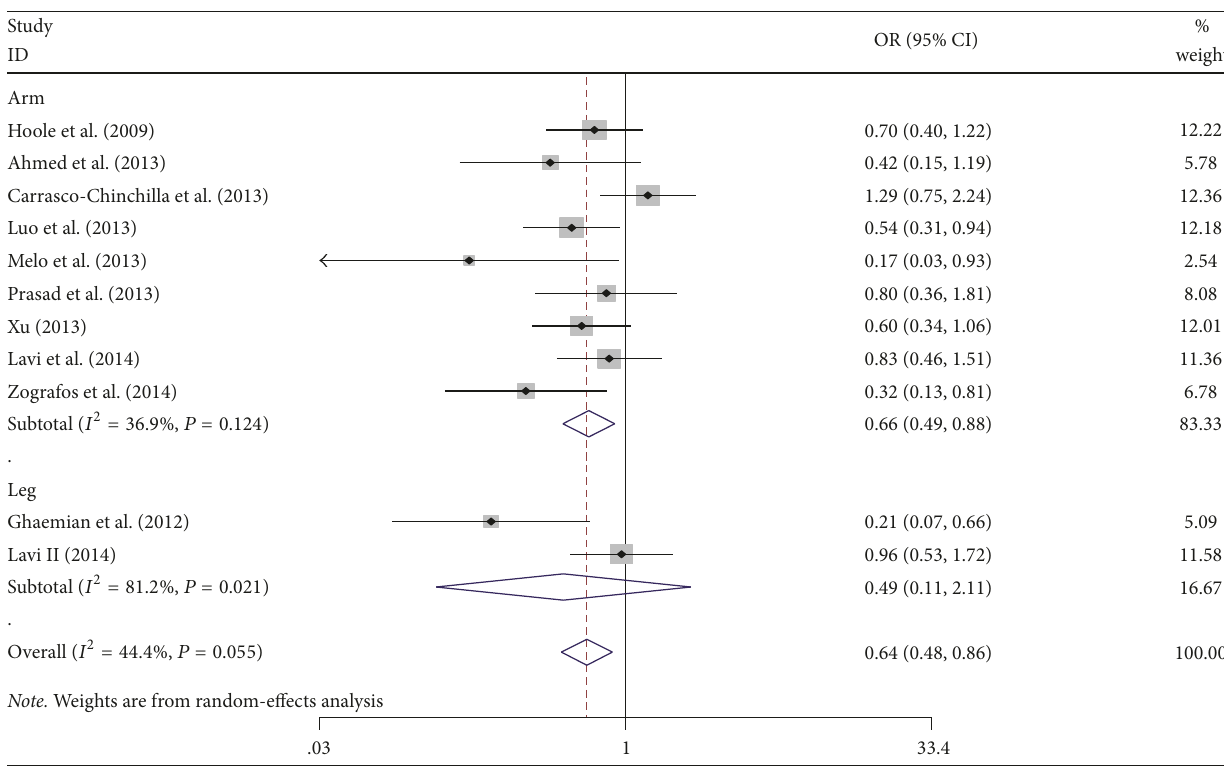
Figure 2: Forest plot for the incidence of perioperative myocardial infarction (PMI). RIPC: remote ischemic preconditioning; OR: odds ratio.